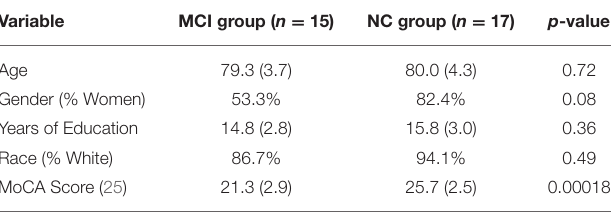
TABLE 1 | Demographic characteristics by baseline cognitive status.